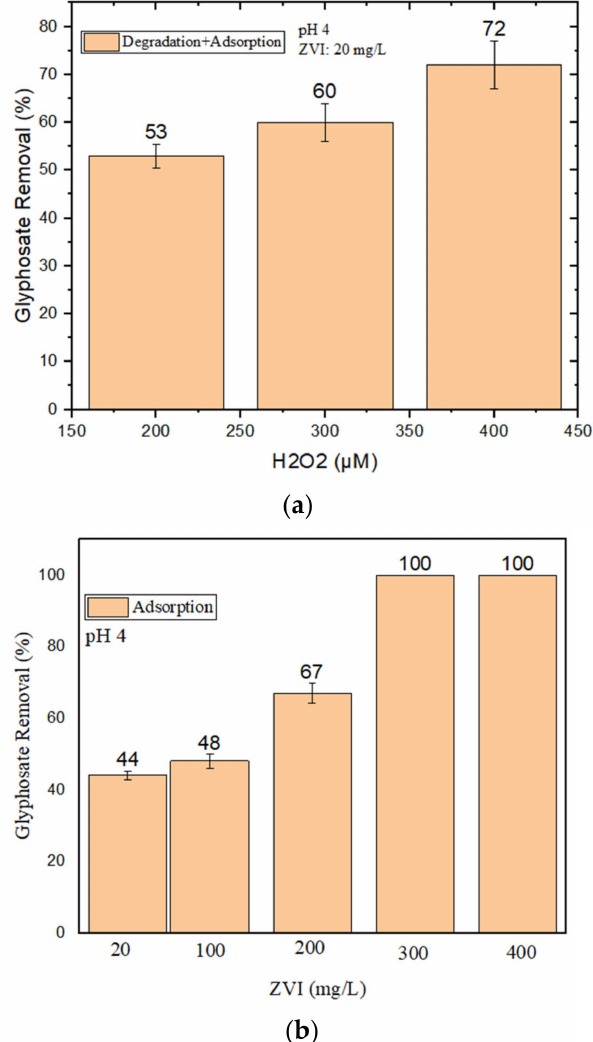
Figure 2. ( a ) GLY removal (%) by nZVI (20 mg/L) and H 2 O 2 (200–400 µ M) at pH 4; ( b ) GLY removal at pH 4 by nZVI alone (with different loadings).